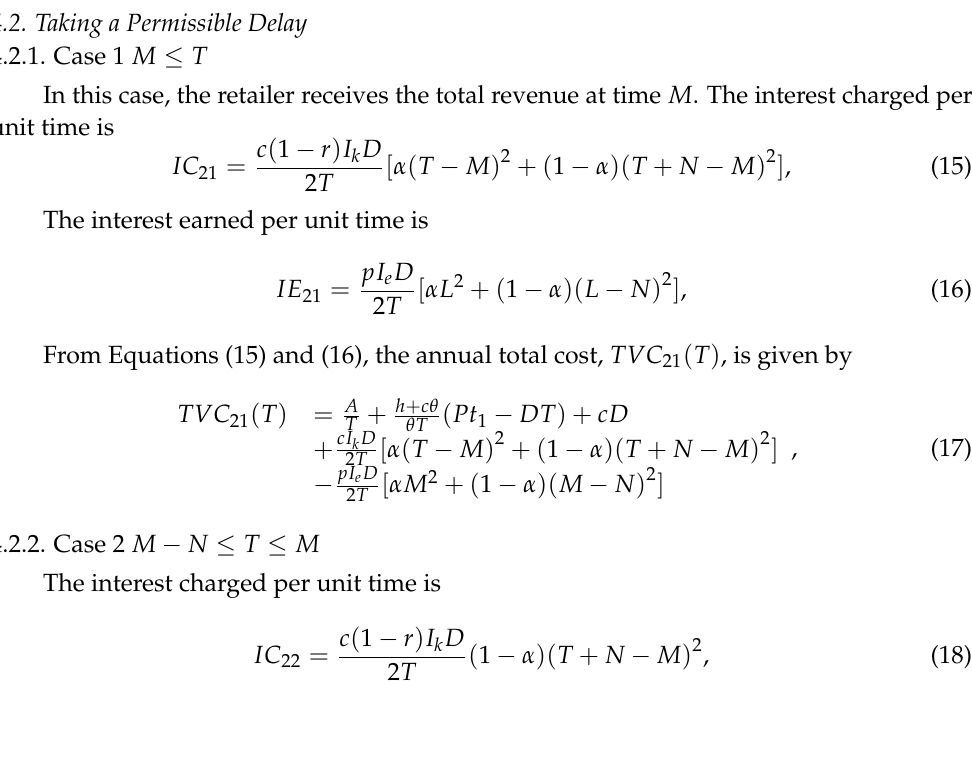
Figure 3. Graphical representation of T ≤ L − N